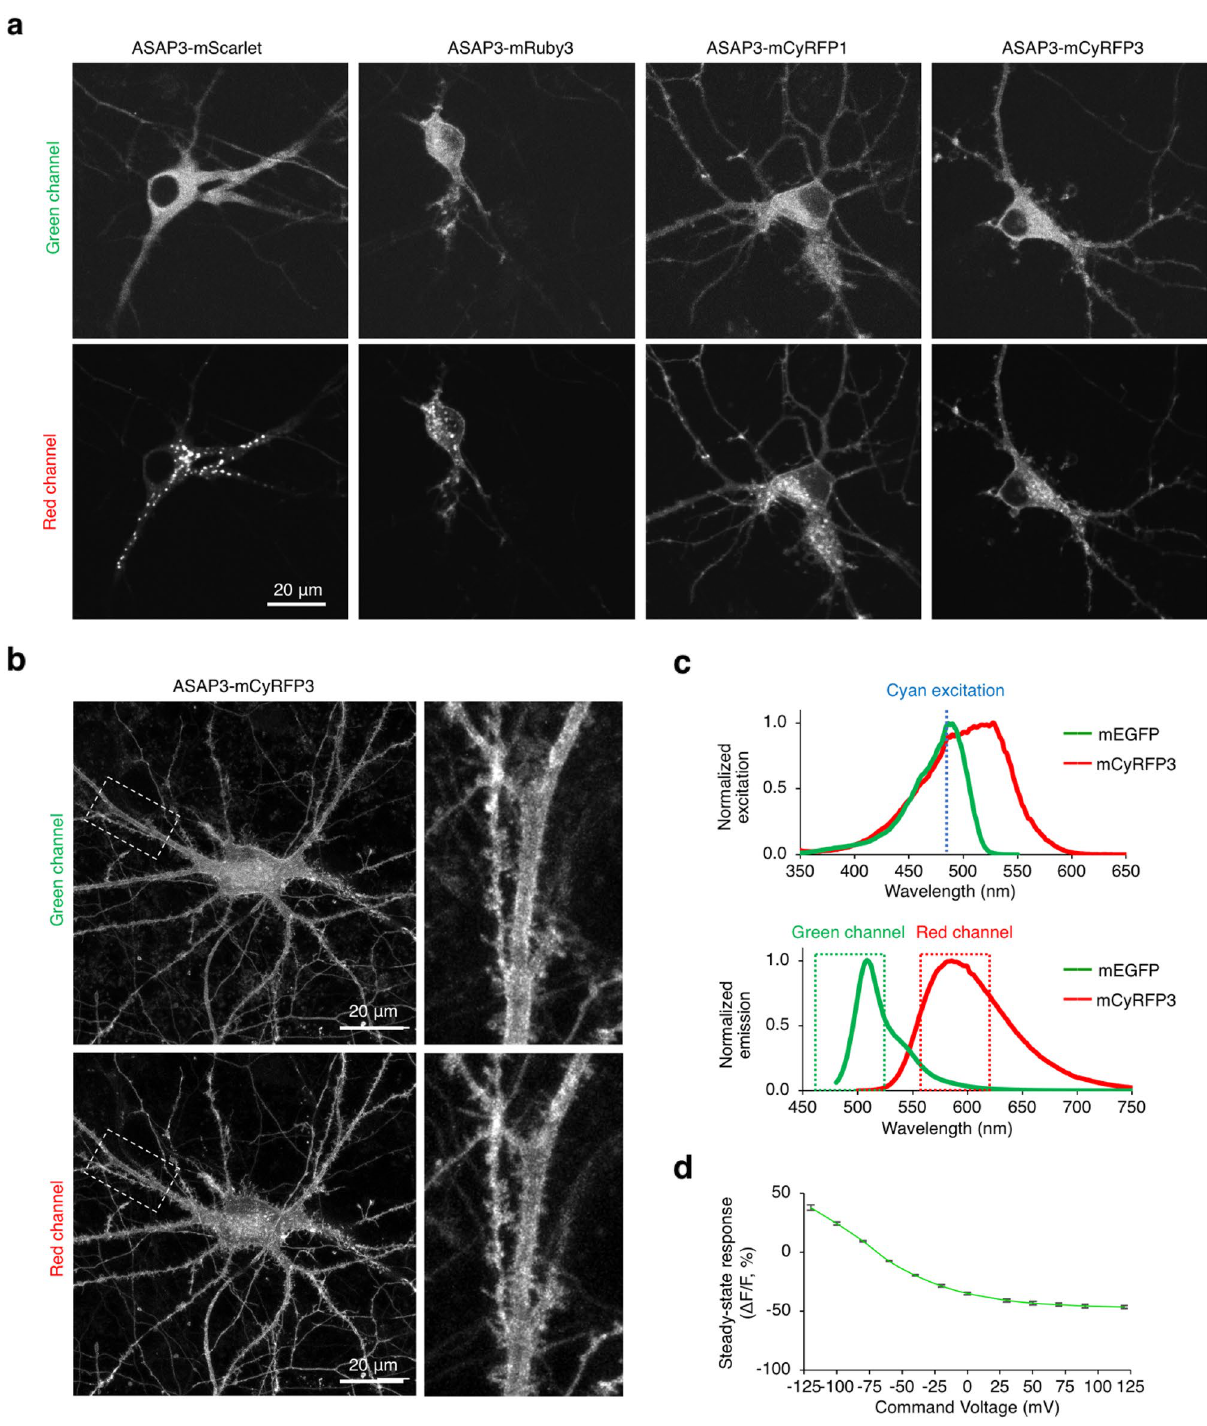
Figure 3. Characterization of ASAP3-mCyRFP3 (ASAP3-R3). ( a ) Representative images of ASAP3 fusions to various RFPs expressed in primary rat hippocampal neurons acquired on a spinning-disk confocal microscope using Improvision Volocity 6.0 and processed in NIH Fiji 2.1. ( b ) Laser-scanning confocal images of ASAP3-R3 in a rat hippocampal neuron. Images were acquired with Zeiss Zen Blue software and processed in Fiji 2.1. ( c ) Above, normalized excitation spectra of mCyRFP3 and mEGFP, showing a single excitation wavelength can be used. Below, normalized emission spectra of mCyRFP3 and mEGFP, showing their emissions are separable ( d ) Steady-state voltage responsivity of ASAP3-R3. Error bars represent standard error of the mean (n = 8 HEK293 cells). Graphs were made in Microsoft Excel for Mac